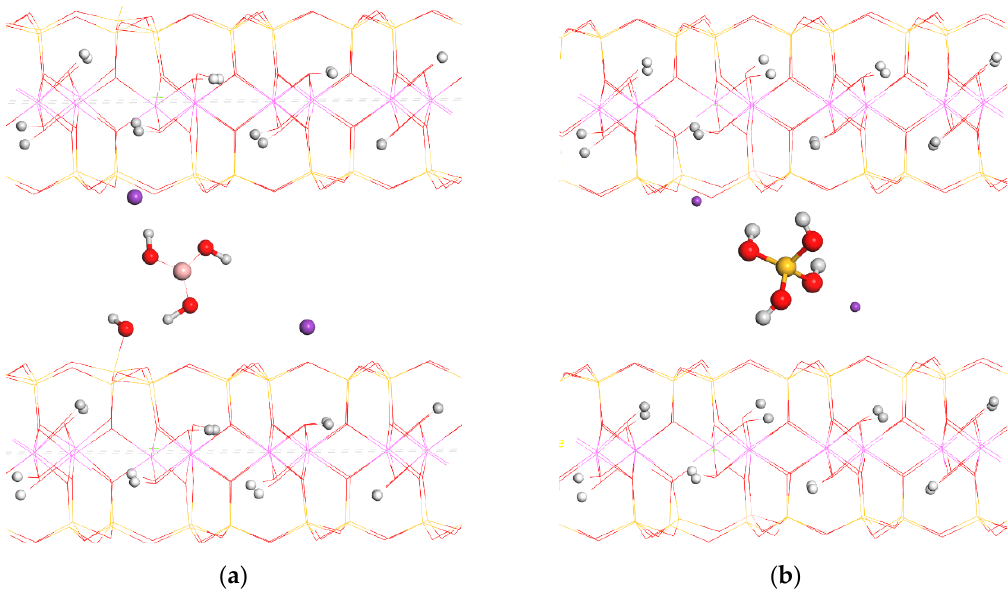
Figure 8. Optimized crystal structures of montmorillonite with: interlayer B(OH) 3 model ( a ); and montmorillonite with tetrahedral B and Si(OH) 4 in the interlayer model ( b ). The H, O, K, Si, Al and B are represented in light-grey, red, fuchsia, pink and orange, respectively.